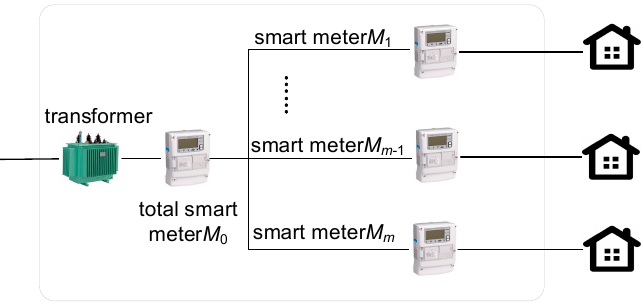
Figure 4. Topology of typical power distribution area.